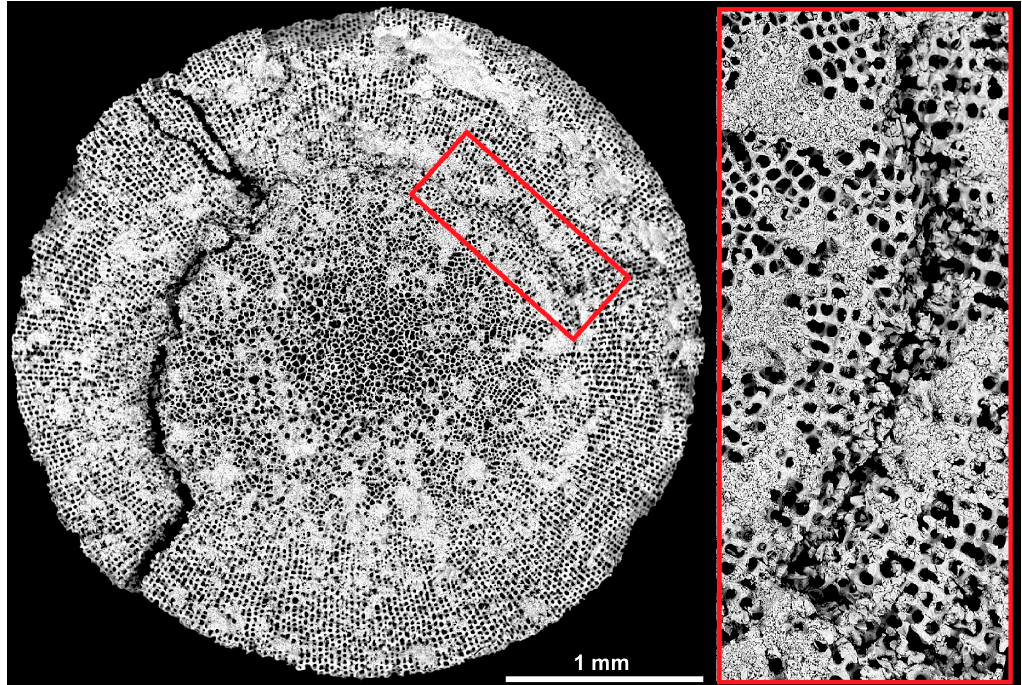
Figure 14. Cross sectional BSE image of the spine’s core of Phyllacanthus imperialis , which was uniaxial loaded until the first acoustic signal occurred. Initial crack propagation at the medulla-radiating layer interface is displayed in high magnification in the red box. The advanced stage of crack propagation is demonstrated on the left-hand side: the crack is deflected along the stereom sheet.